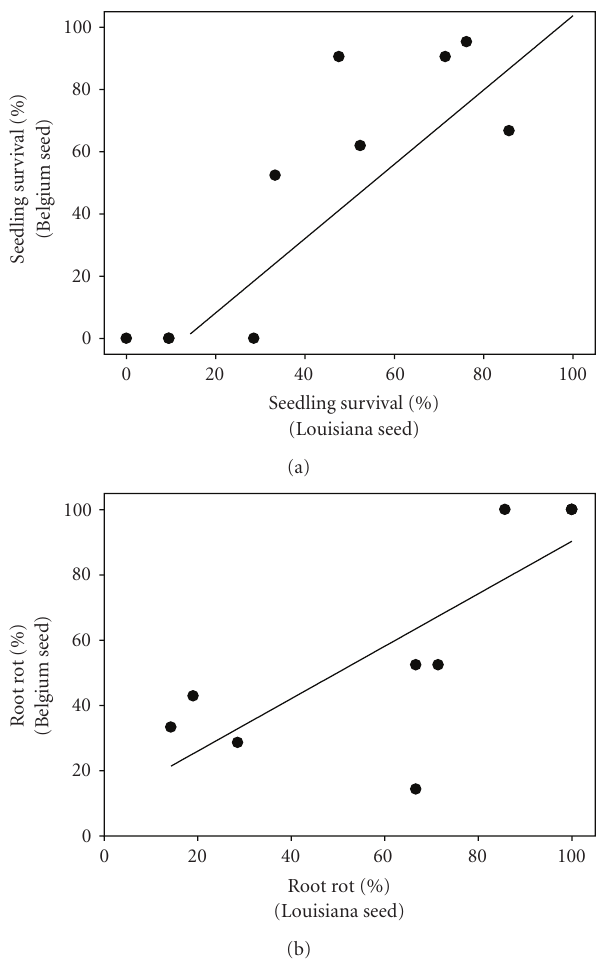
Figure 1: Positive correlation of Prunus serotina seed originating from its native ( x -axis, Louisiana, USA) and nonnative ranges ( y - axis, Belgium) for % seedling mortality and % root rot results. A positive correlation suggests that the pathogenic activity of the isolates does not depend on host genotype. Each symbol represents the average response of experimental units ( n = 3 vessels per isolate) to a given isolate while interacting with seedlings from either the native range ( x -axis) or nonnative range ( y -axis). Some data points overlap ( n = 10). All isolates were from the native range and represent a di ff erent pool of isolates than shown in Figure